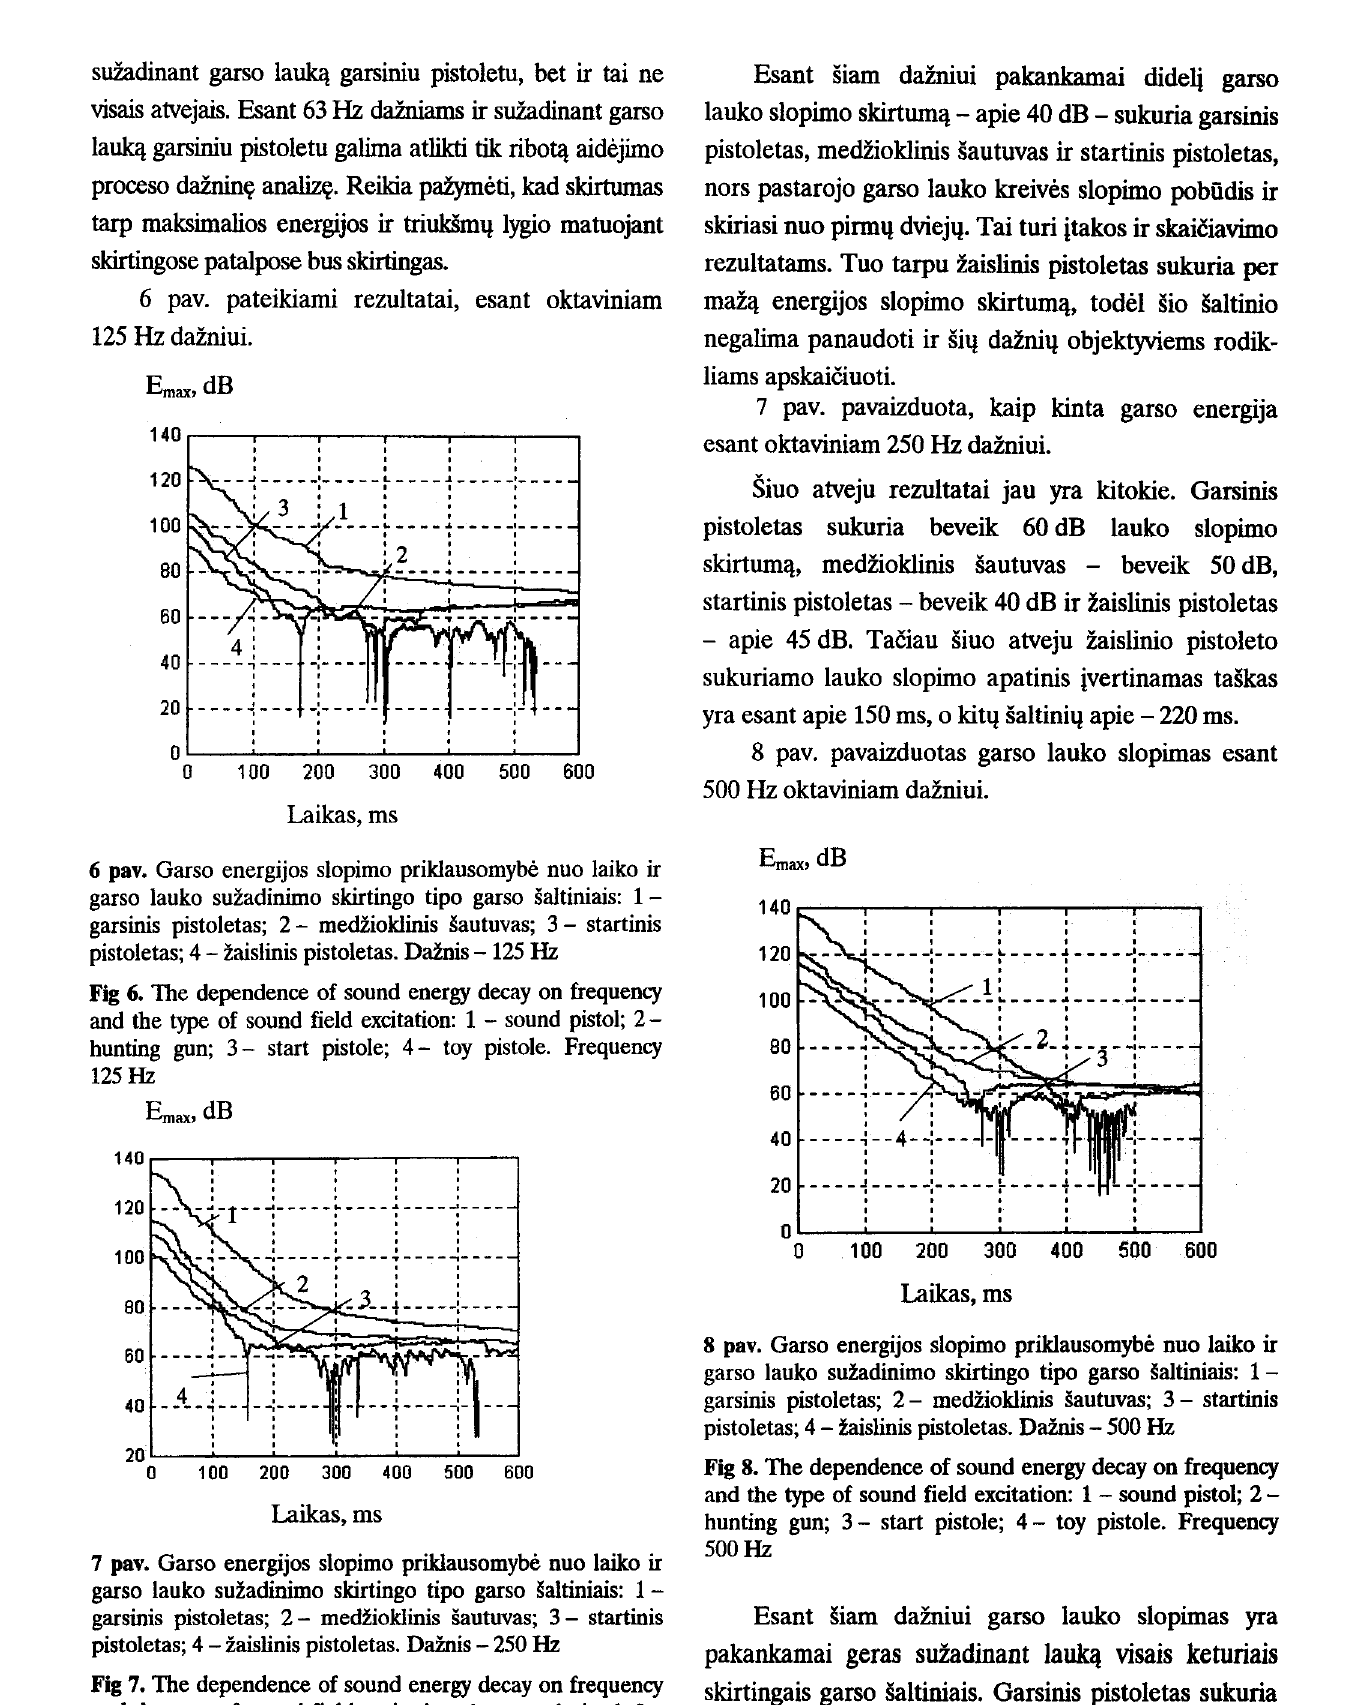
garso lauko suzadinimo skirtingo tipo garso saltiniais: 1 - garsinis pistoletas; 2 - medzioklinis sautuvas; 3 - startinis pistoletas; 4 - zaislinis pistoletas. DaZnis - 250 Hz Fig 7. The dependence of sound energy decay on frequency and the type of sound field excitation: 1 - sound pistol; 2 - hunting gun; 3 - start pistole; 4 - toy pistole. Frequency